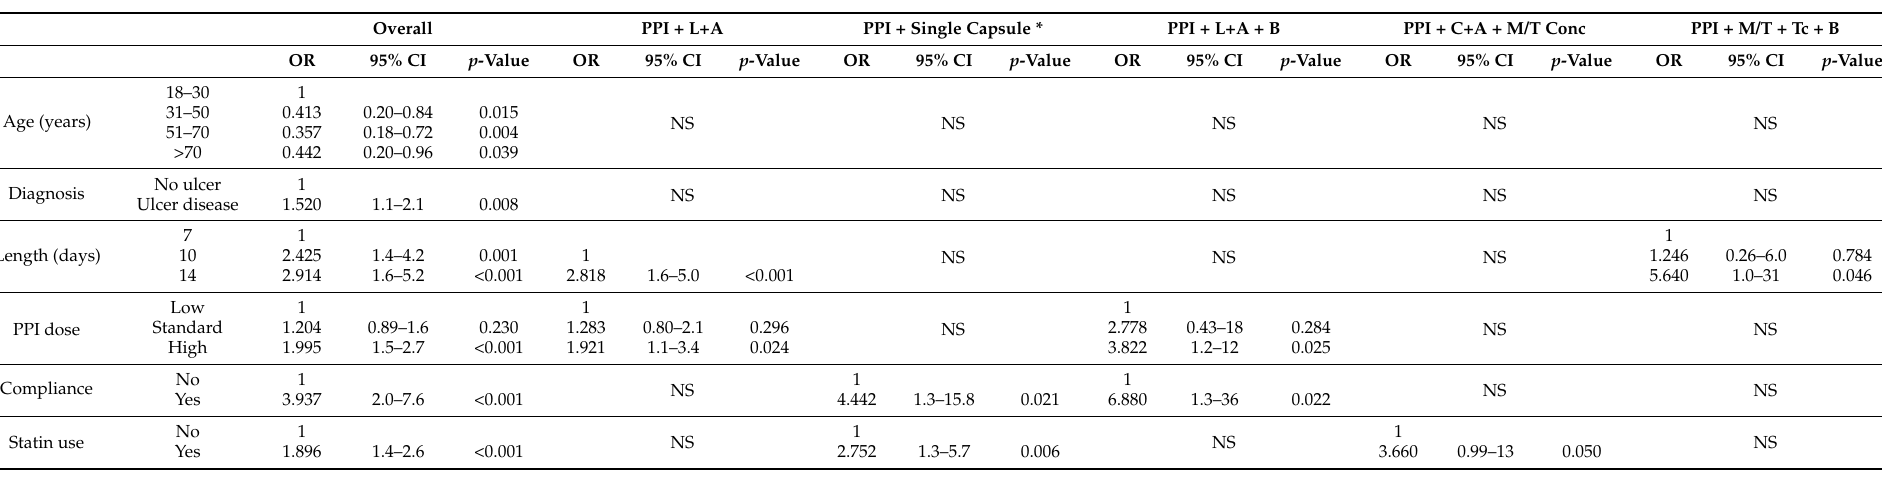
Table 8. Multivariate analysis of mITT effectiveness in rescue attempts according to empirically prescribed therapies: 2nd–6th lines.